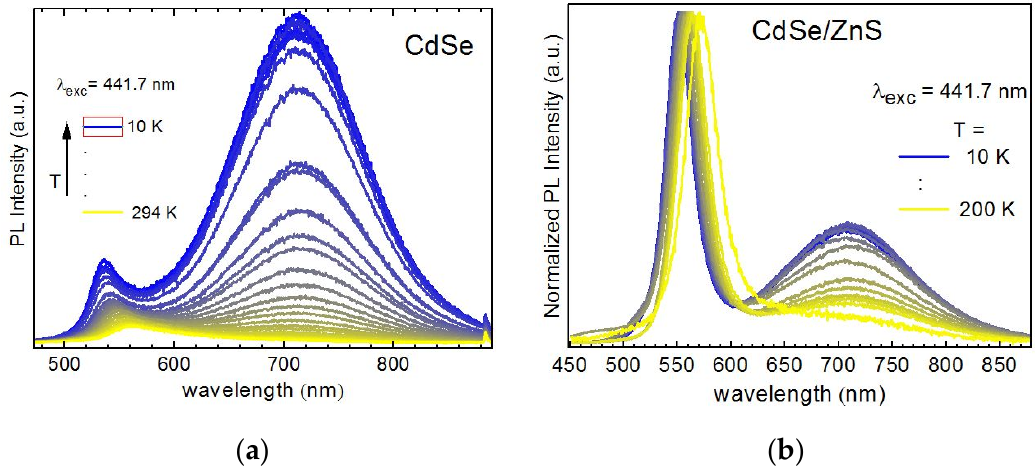
Figure 7. Temperature dependence of the PL spectra of CdSe ( a ) and CdSe / ZnS ( b ) NCs in gelatin matrix ( λ exc = 441.7 nm, 0.1 W / cm 2 ).